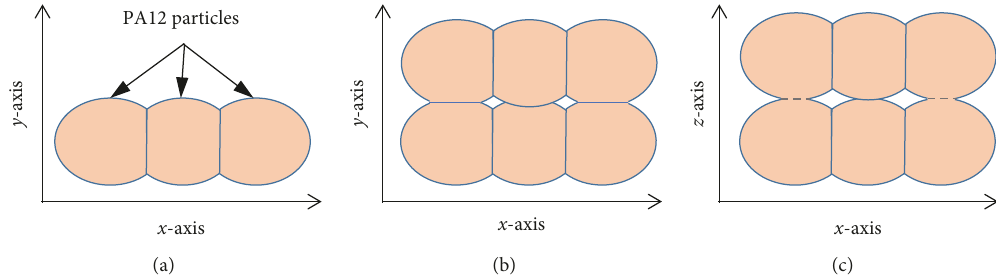
Figure 3: Schematics of bonding mechanism between PA12 particles in SLS: (a) strong bonds formed along the x -axis; (b) weak bonds between successive scan paths along the y -axis; (c) weakest bonds between layers along the z -axis.